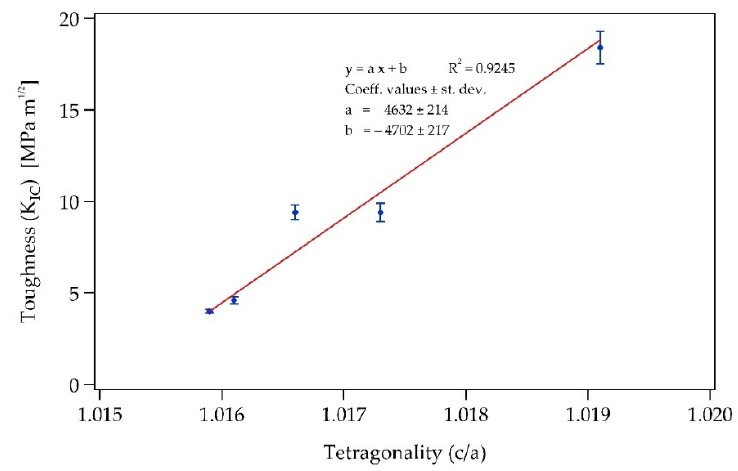
Figure 1. Fracture toughness vs. tetragonality of the different stabilizers in zirconia-based materials.